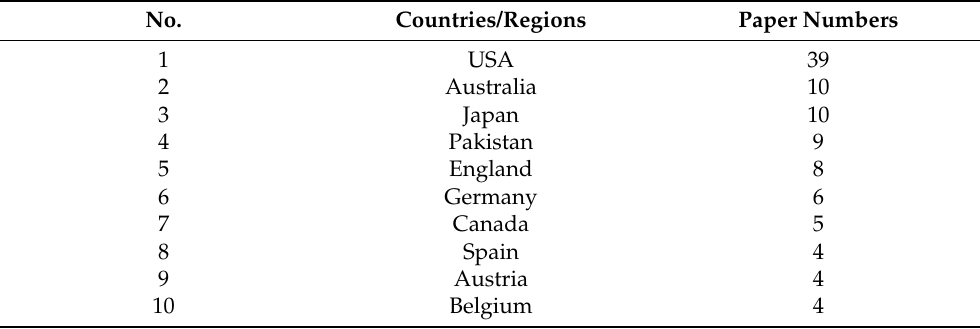
Table 3. The main cooperative countries and regions of China’s dynamic disaster monitoring and early warning international research (2000–2021).